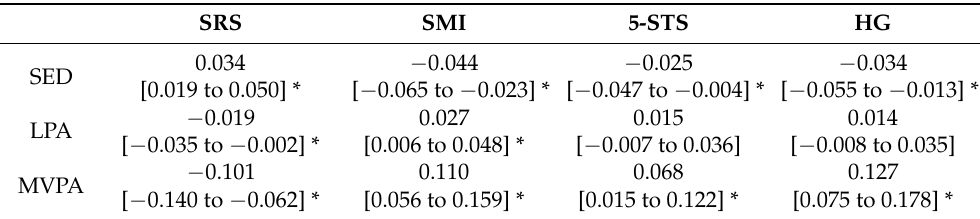
Table 2. Associations (ß-coefficient, 95% CI) between time spent in different physical activity intensi- ties and SRS and its components. SRS